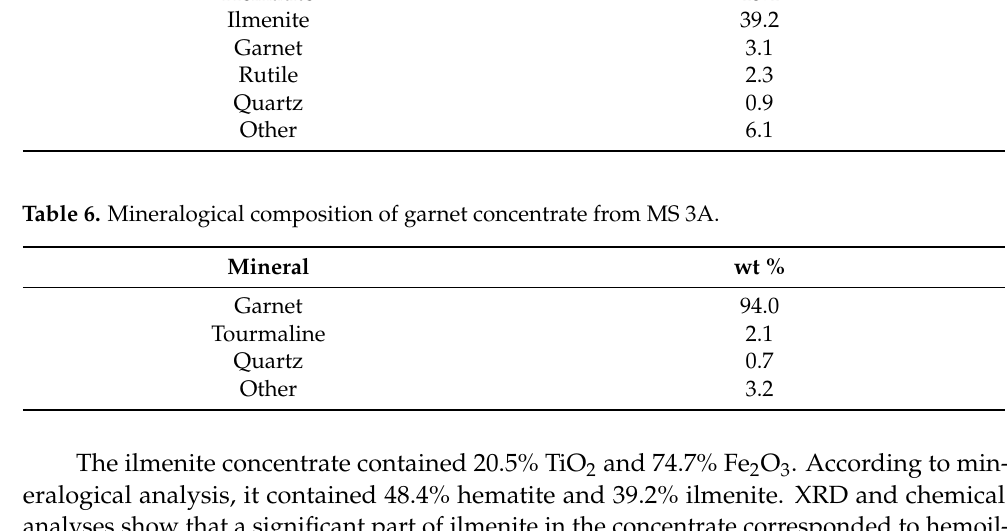
Table 5. Mineralogical composition of ilmenite concentrate from MS 1A.